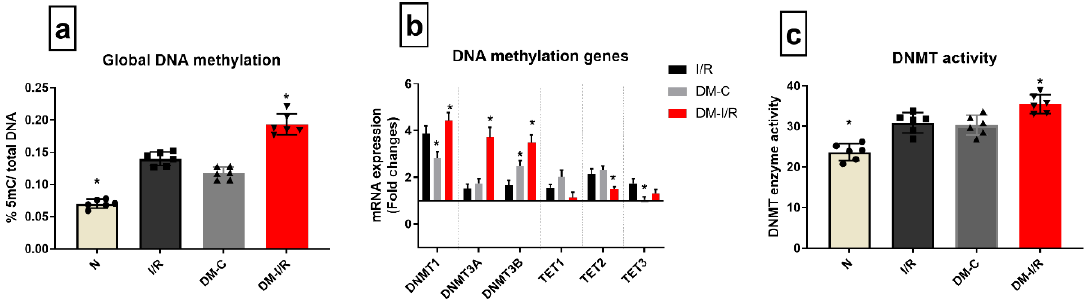
Figure 3. Methylation changes in I/R challenged DM rat hearts: The methylation changes in the DM I/R hearts were assessed from ( a ) global DNA methylation; ( b ) the mRNA expression of DNA methylation enzymes DNMT1 , 3A , 3B , TET1 , 2 , 3 (expressed as fold changes from normal); ( c ) DNMT enzyme activity. The graphs represent mean ± SD values. * p < 0.05 vs. I / R.